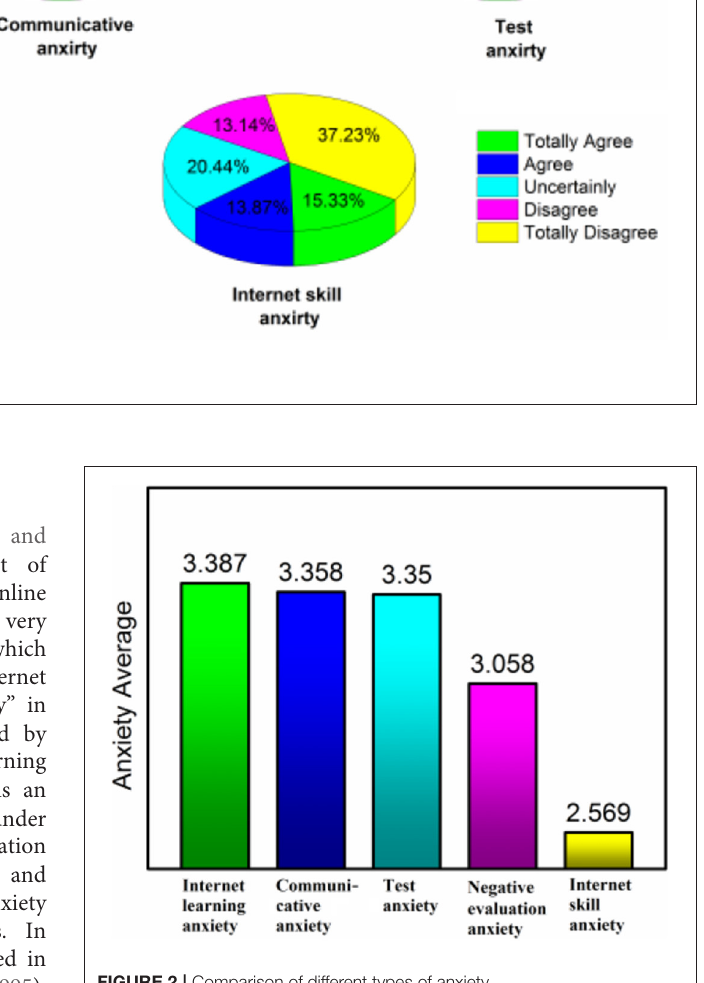
FIGURE 2 | Comparison of different types of